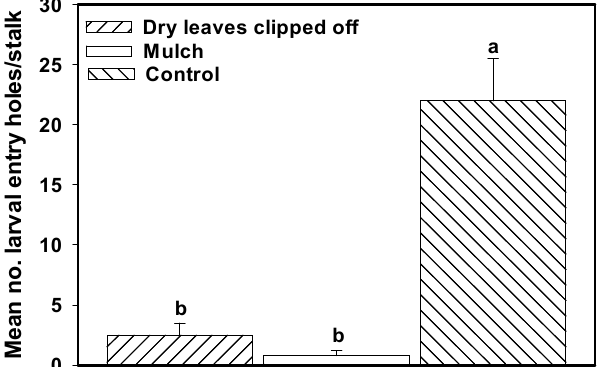
Figure 1. Mean (± SE) numbers of E . loftini larval entry holes per sugarcane stalk in greenhouse no ‐ choice cage assays where the curls and folds along the edges of dry leaf tissue were excised, dry leaves were placed on the cage floor at a sort of “mulch”, or plants were left intact and without “mulch” as a control; different letters over bars indicate significant differences ( p < 0.05) [54].